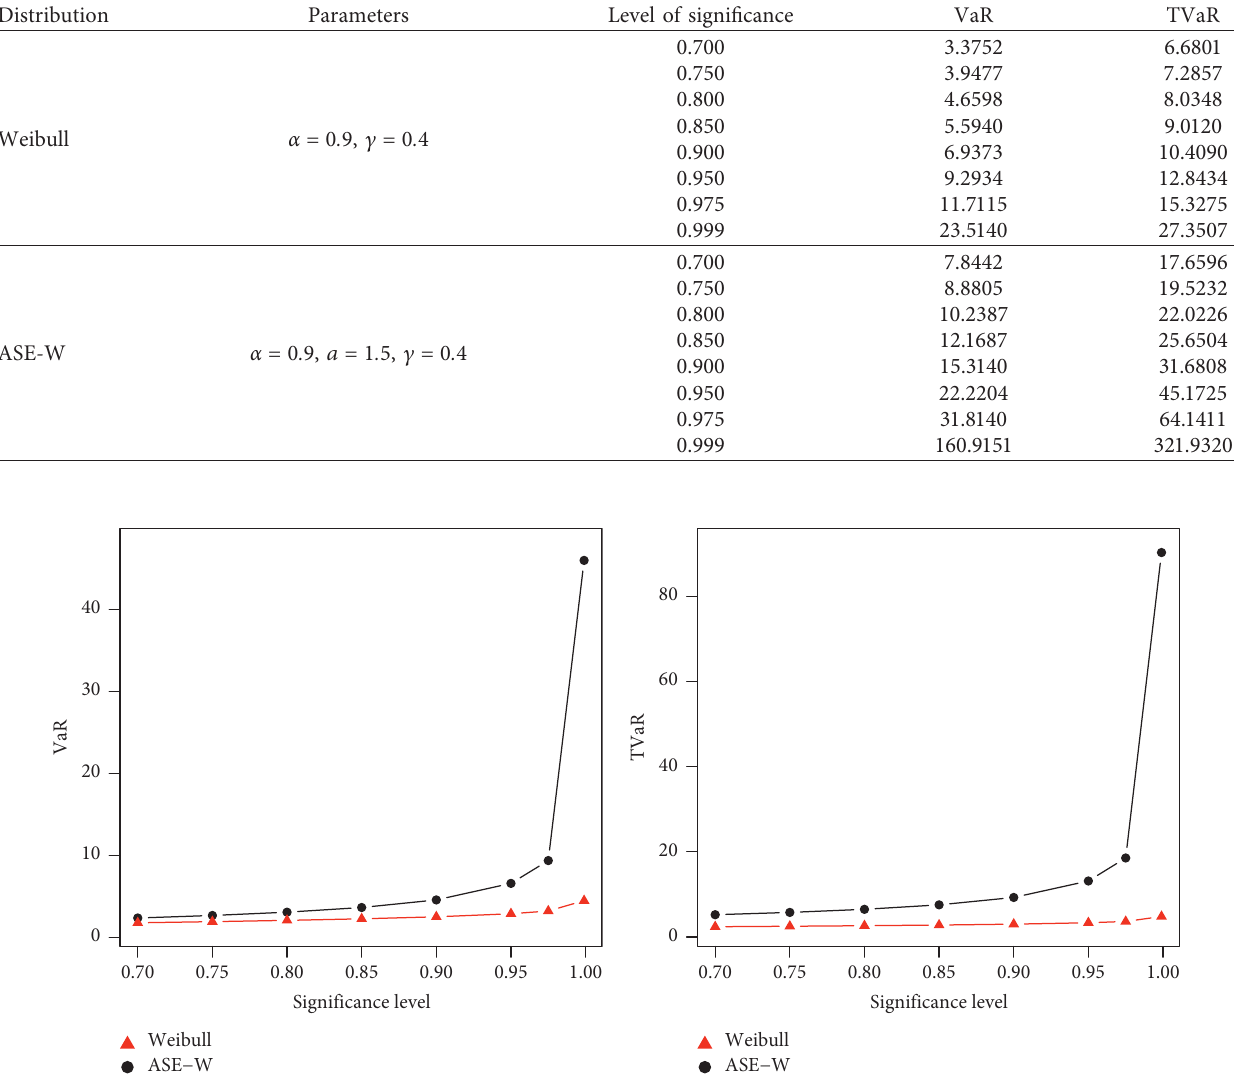
Table 6: Simulation results of the actuarial measures at different levels of significance for α � 0 . 9, c � 0 . 4, and a � 1 . 5.